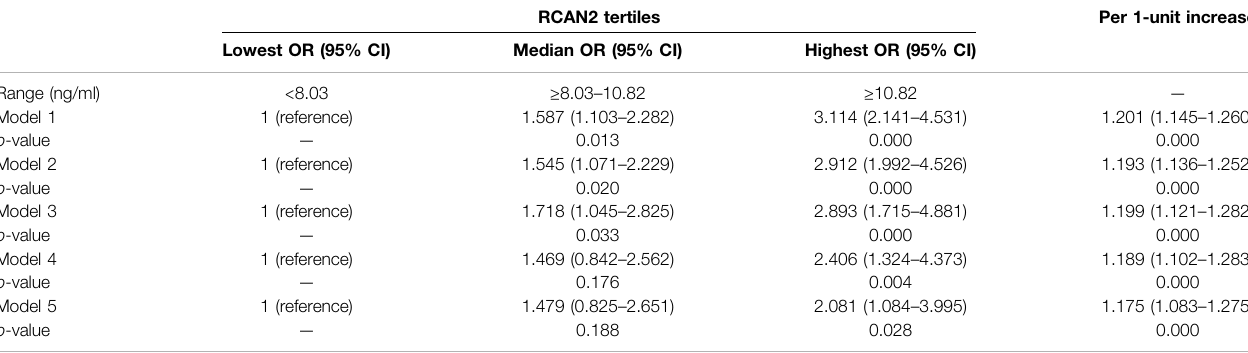
TABLE 4 | Binary logistic regression of NAFLD risks according to tertiles or per 1-unit increases of serum RCAN2 concentrations. RCAN2 tertiles Per 1-unit increase Lowest OR (95% CI) Median OR (95% CI) Highest OR (95% CI) Range (ng/ml) < 8.03 ≥ 8.03 – 10.82 ≥ 10.82